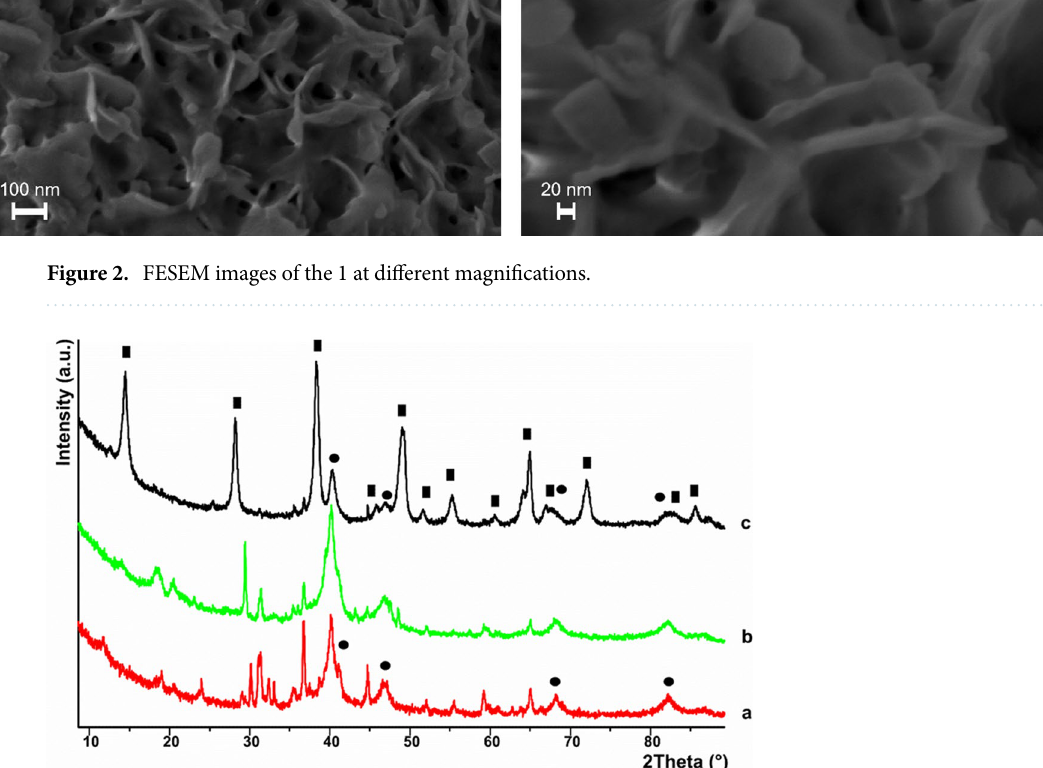
Figure 3. PXRD spectra acquired at room temperature for (1): ( a ) as-synthesized, ( b ) after photochemical reaction and ( c ) after thermal reaction. Full rectangles and circles are assigned to the Bragg reflexes belonging to AlO(OH) and fcc Pd,